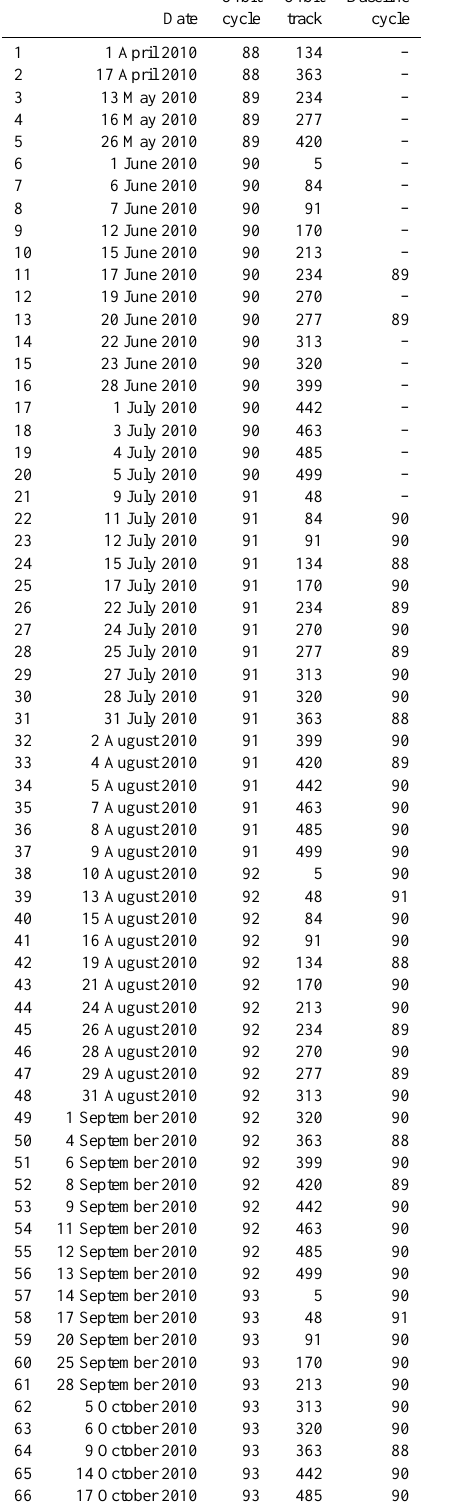
Table 1. GM Data used in this study. The Baseline Cycle refers to the orbit cycle corresponding to the deducted baseline data.